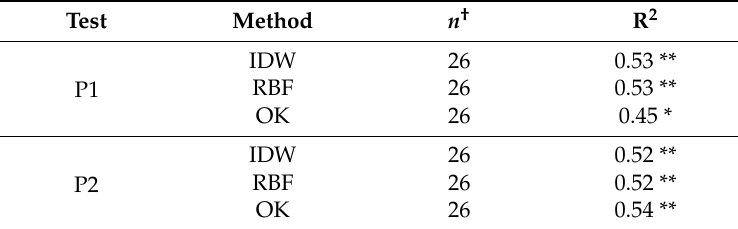
Figure 9. Correlation between experimental and estimated values of As(ln) in P2 by ( a ) IDW, ( b ) OK, and ( c ) RBF. Table 5. Accuracy of interpolation methods IDW, OK, and RBF through R 2 for P1 and P2.